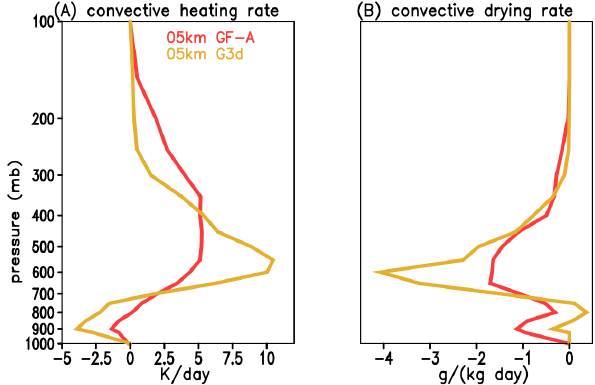
Figure 10: As in Figure 9 A and B, except for runs with GF-A on 5km (red) and G3d on 5km (brown) horizontal resolution Figure 10. As in Fig. 9a and b, except for runs with GF–A on 5km (red) and G3d on 5km (brown) horizontal